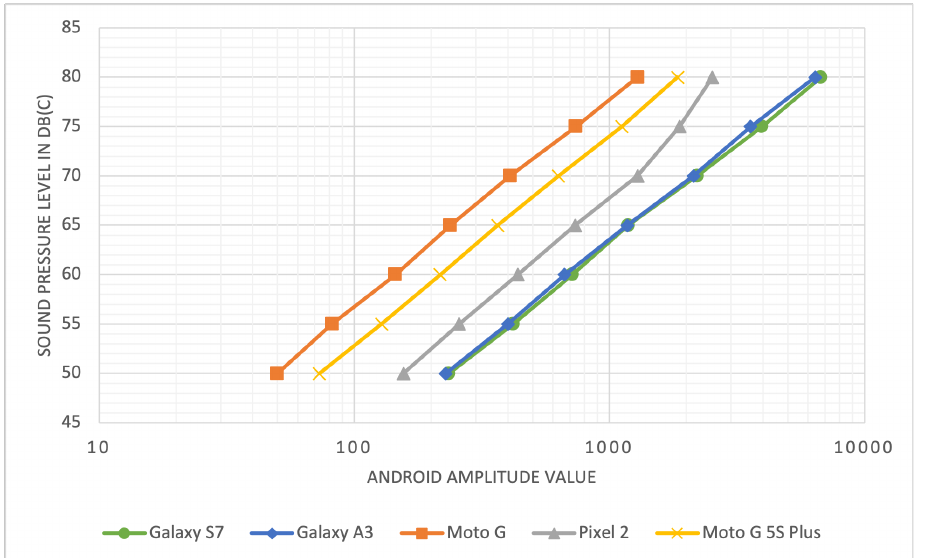
Figure 3. Measured amplitude values for C-weighted sound pressure levels between 50–80 dB(C) for the different mobile devices used in the experiments. The x-axis is logarithmically